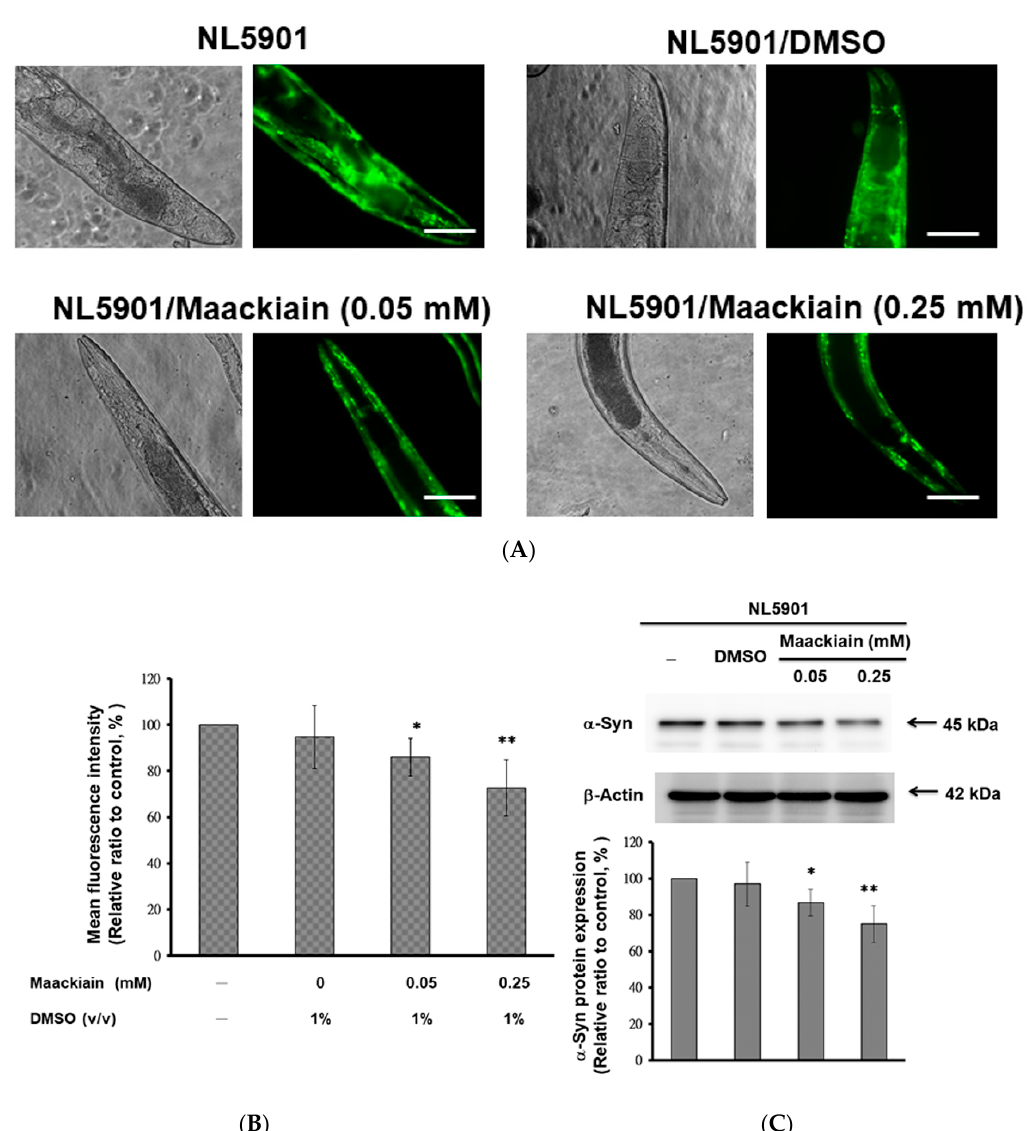
Figure 4. Accumulation of α‐ synuclein ( α‐ Syn) was diminished by maackiain (MK) treatment in the NL5901 strain of C. elegans . L3 stage worms were treated with or without MK and cultured until the third day of adulthood. ( A ) The representative YFP fluorescence images of α‐ Syn accumulation in the muscles of the head region of worms. Scale bar = 50 µm. ( B ) ImageJ software was used to quantify YFP fluorescence intensity for 50 animals per group. ( C ) The protein level of α‐ Syn in the MK ‐ treated and MK ‐ untreated worms was determined by Western blotting. A representative result from one of three independent experiments is shown. The level of β ‐ actin was used as an internal control for loading. The relative fold in α‐ Syn level is represented as the ratio of the MK ‐ treated groups relative to the MK ‐ untreated groups. In the above experiments, * shows significant differences between the MK ‐ untreated and the MK ‐ treated worms (* p < 0.05, ** p < 0.01).